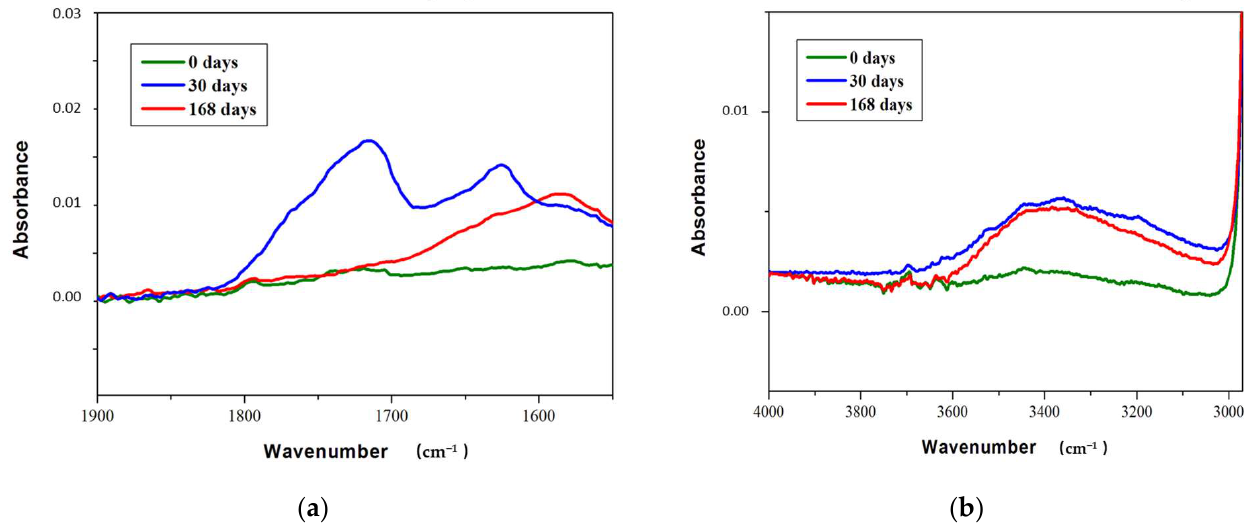
Figure 3. Infrared spectra of PPMCW sample before (0 days), after natural (168 days), and accelerated (30 days) aging ( a ) in the domain 1900–1550 cm − 1 and ( b ) in the domain 4000–3000 cm − 1